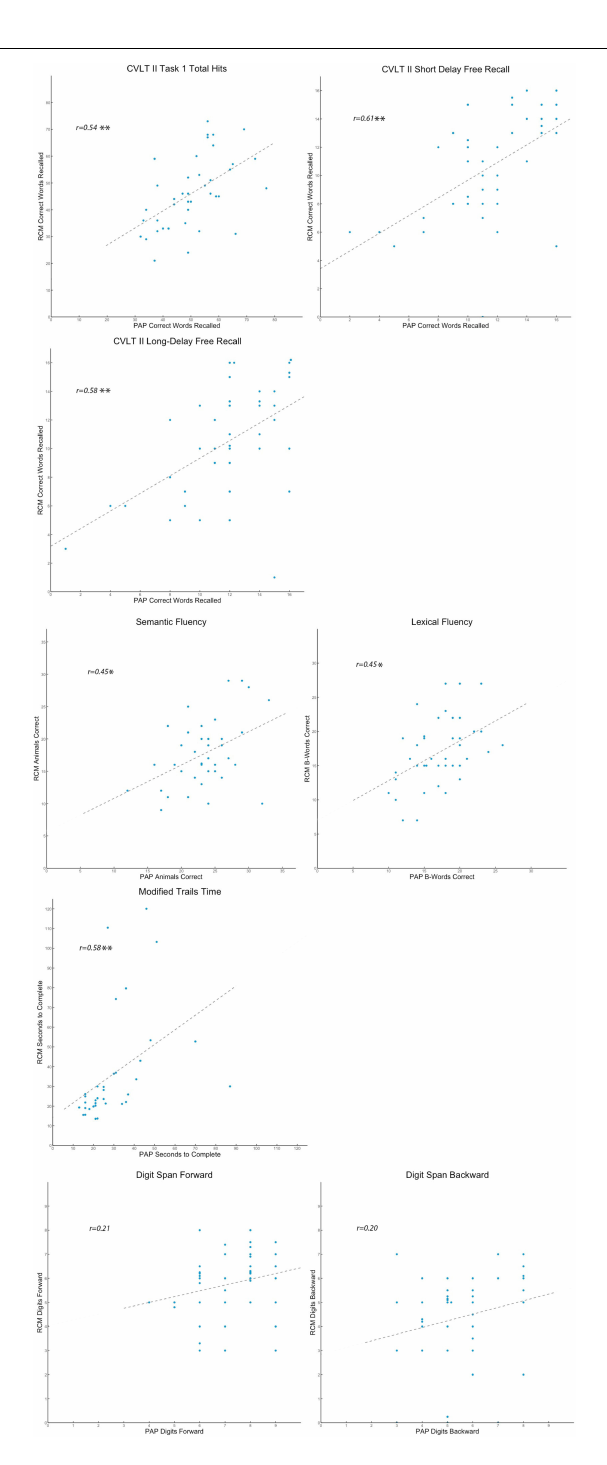
FIGURE 2 | Scatter plots comparing individual differences. Presented separately for the eight standardized tasks, each participant’s raw scores are shown in scatter plots that reflect the pattern of individual differences on that cognitive measure. On each plot, participants’ RCM raw scores for the test variable are indexed by the vertical axis, while their PAP raw scores are indexed by the horizontal axis. A dashed trend line on each plot indicates the best estimate of the Pearson’s correlation ( r- value). For the r- value estimates, * p < 0.05, ** p < 0.01, and *** p <